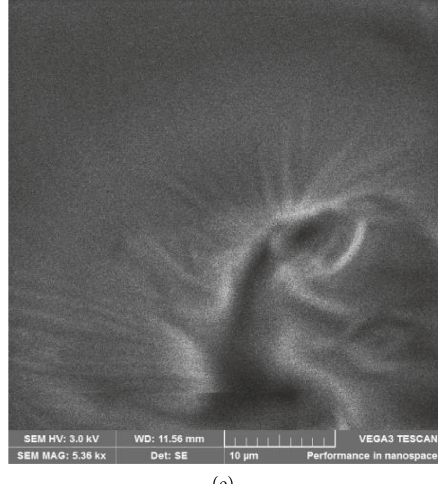
Figure 2: SEM images of neat and BG-modified bitumen samples. (a) Neat binder. (b) 3% BG by weight of binder. (c) 6% BG by weight of binder. (d) 9% BG by weight of binder. (e) 12% BG by weight of binder.